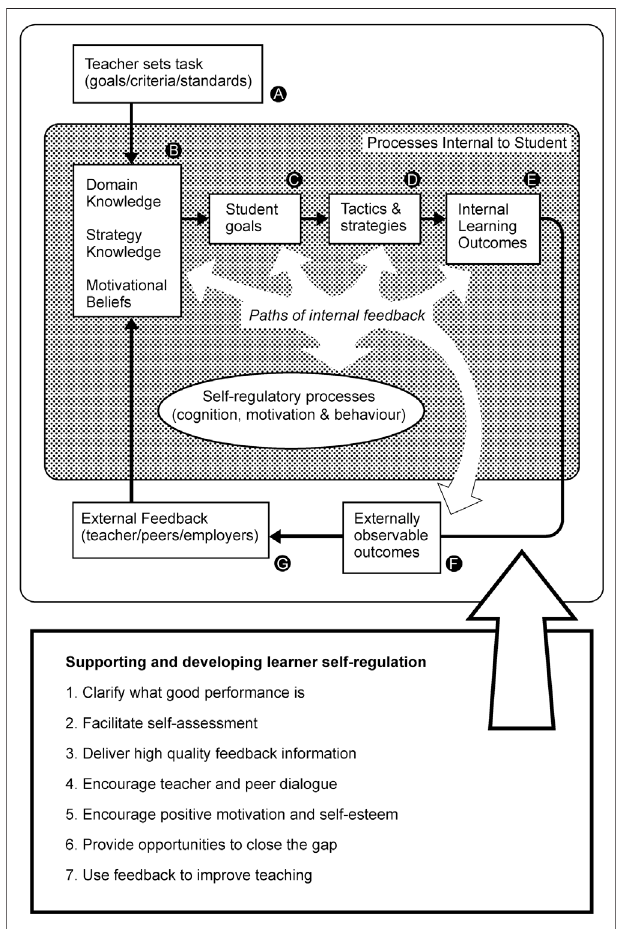
FIGURE 11 | Nicol and MacFarlane-Dick (2006)